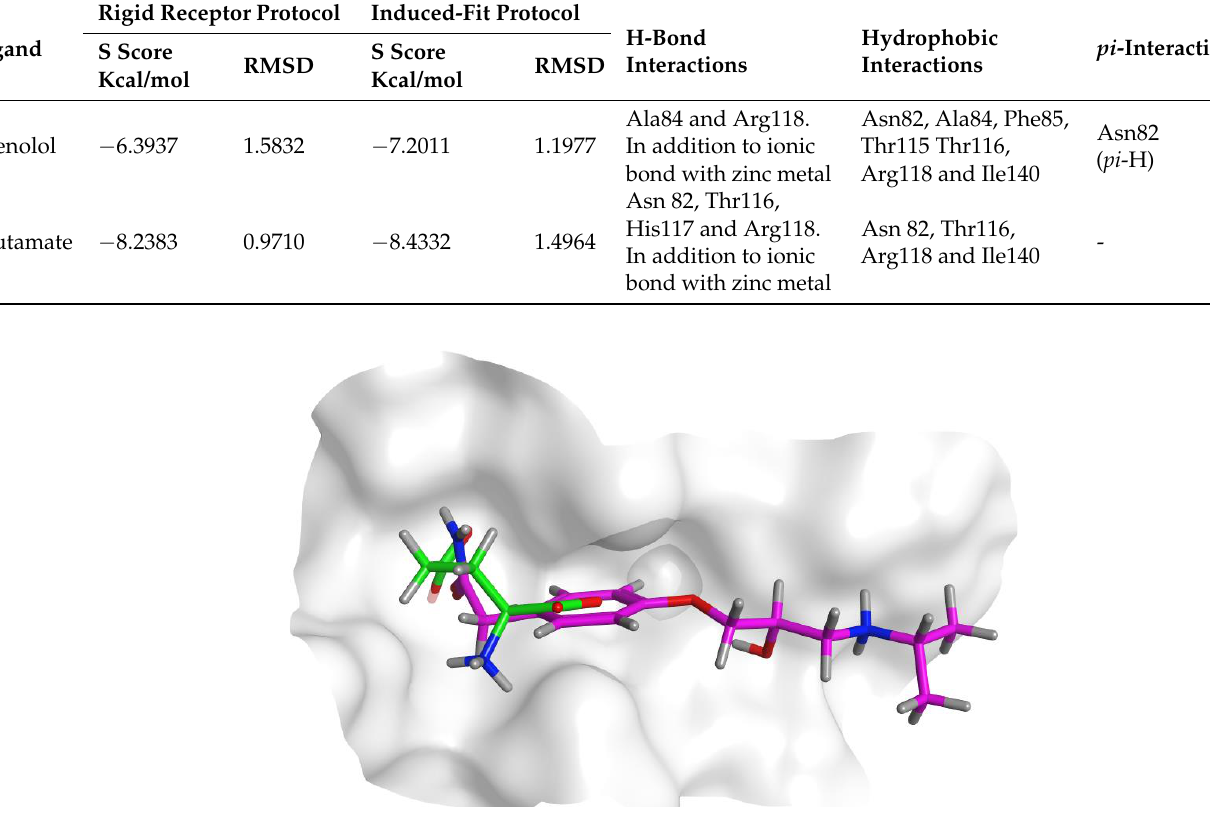
Table 2. Docking results for both glutamate and atenolol with P. mirabilis adhesin MrpH.